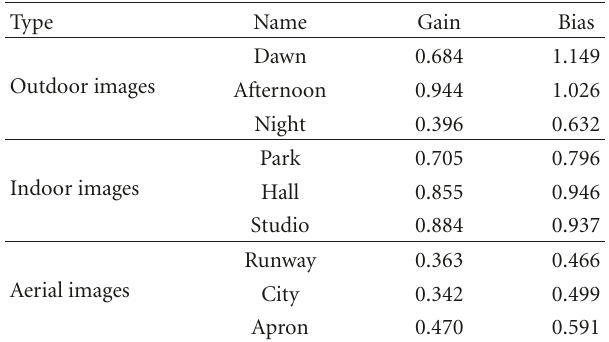
Table 1: Gain and bias